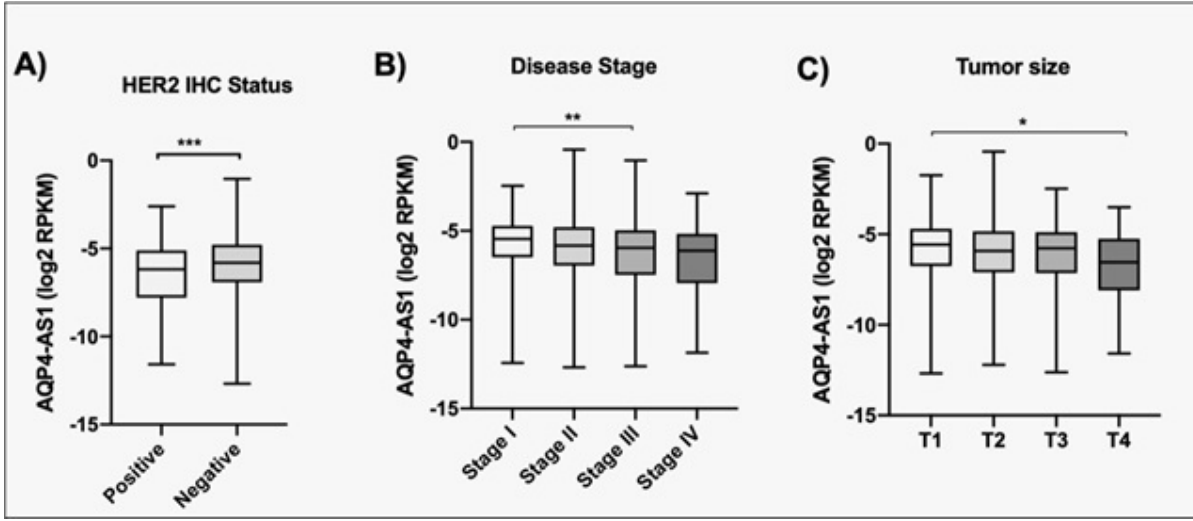
Figure 3 – Expression of AQP4-AS1 according to immunohistochemical (IHC) markers, stage and size of tumor. A. Epidermal growth factor receptor 2 (HER2) status, B. Stage of disease and C. Size of Tumor, dates from TCGA RNA-seq data . * p < 0.05, ** p < 0.001 *** p <